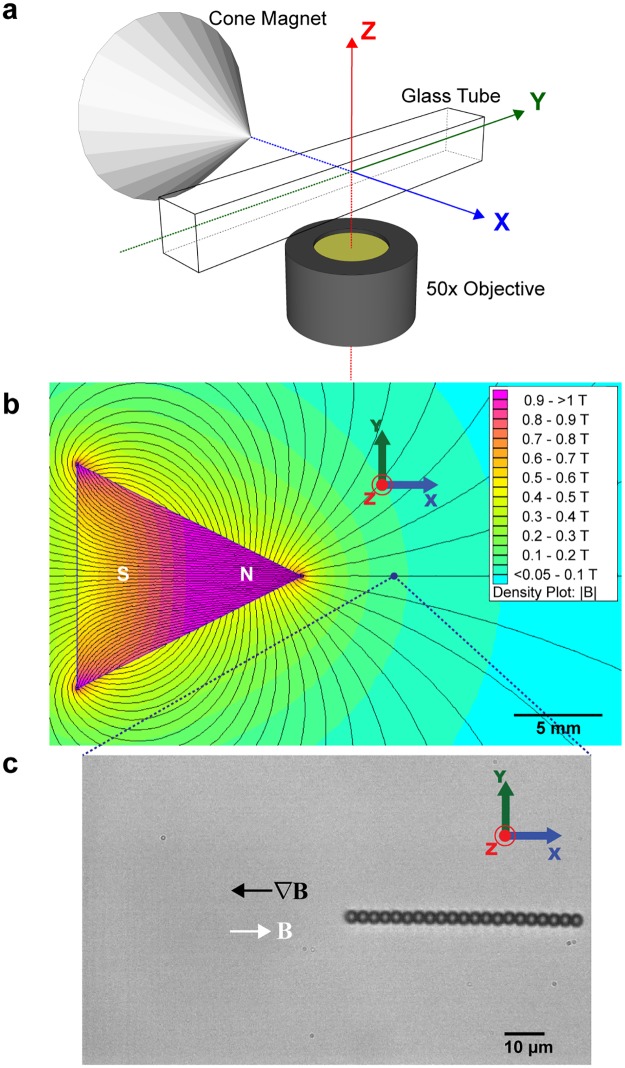
Magnetic tweezers setup for parallel translation of bead chains.(a): Schematic representation of the magnetic tweezers with a single cone magnet, which is magnetized north at tip and south at base. (b): Finite element simulation of the cone magnet using Finite Element Method Magnetics (FEMM 4.2). Cross section of the x, y-plane through the geometric center along z-axis is shown. Field density |B| decreases from pink to blue. N and S denote north and south poles respectively. Black lines represent computed magnetic field lines. Blue dot is a schematic field of view of the 50X objective, and blue dotted lines show zoom direction. Scale bar, 5 mm. (c): A 21-bead chain in the magnetic field of a single cone magnet, aligning with the field B (white arrow) along the x-axis, and translating towards the magnetic field gradient ∇B (black arrow). The force applied to the particle is in the direction of the magnetic field gradient ∇B. Scale bar, 10 μm.